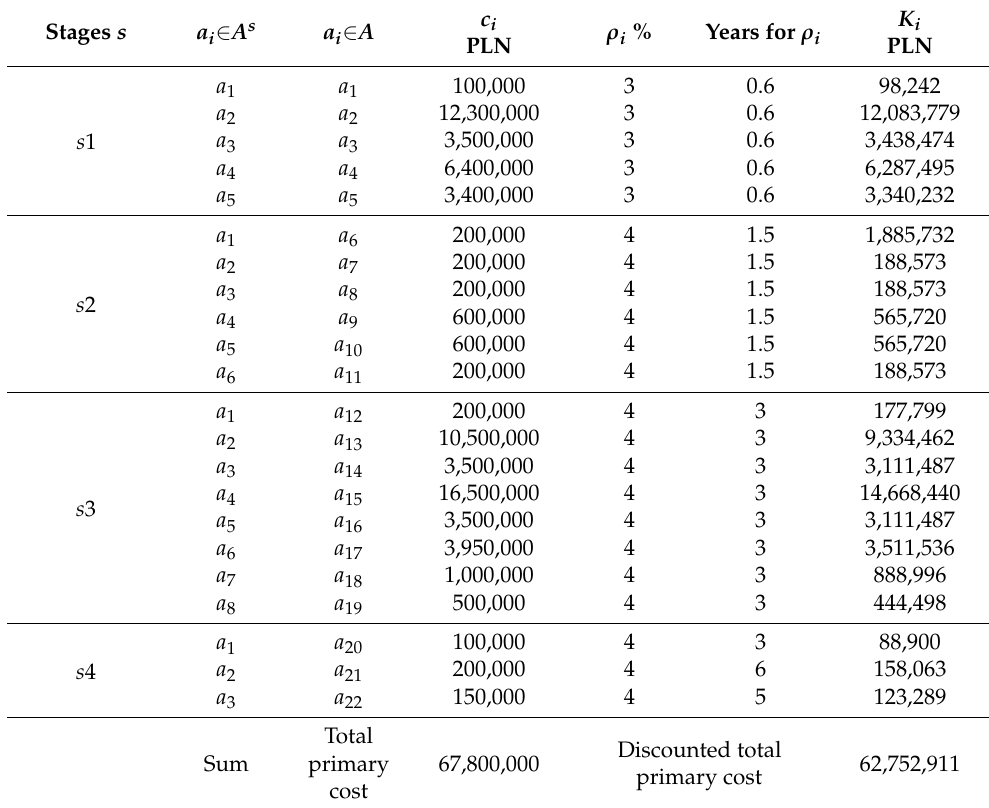
Table 1. Primary initial data for costs.